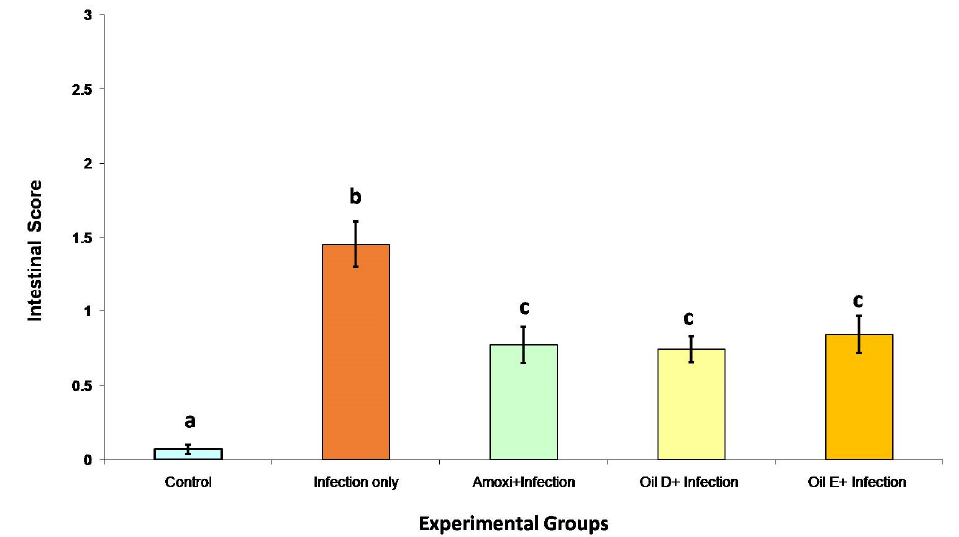
Figure 5. Overall NE lesion score for the entire length of the small intestine. The score sum for all the separate intestinal portions (duodenum, jejunum, and ileum) ranges from 0 to 3. All the control groups reflect the basal intestinal scores in the presence of intestinal stressors (nutritional and coc- cidial overdose vaccination). The values are means ± S.E. Different letters represent statistically sig- nificant differences with a p -value less than